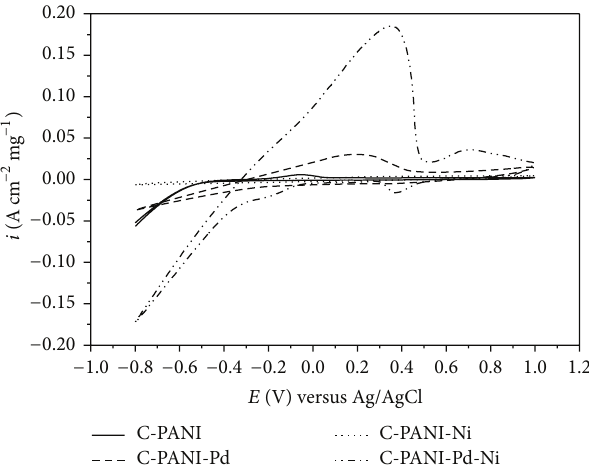
Figure 4: Cyclic voltammograms for methanol oxidation on differ- ent electrodes in 0.5M H 2 SO 4 solution containing 1.0 M methanol at a scan rate of 50 mVs −1 at room